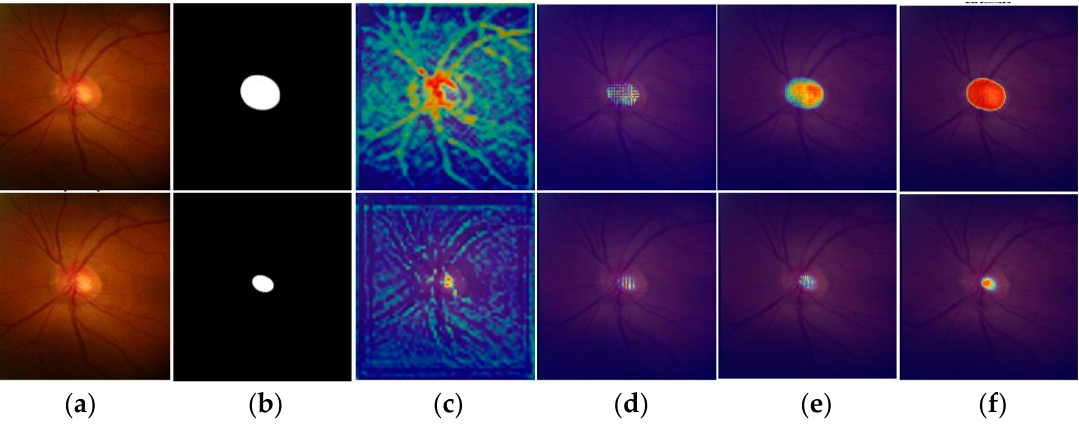
Figure 13. Visual explanation of FEDS-Net learning process using heat activation maps with Rim- One-r3 database. Activation maps for the OD and OC are provided in rows 1 and 2, respectively. ( a ) Input image. ( b ) groundtruth image. Heat activation maps extracted from ( c ) Initial layer, ( d ) first convolutional layer after IA-2, ( e ) convolutional layer after ECD, and ( f ) final convolutional layer of the network.